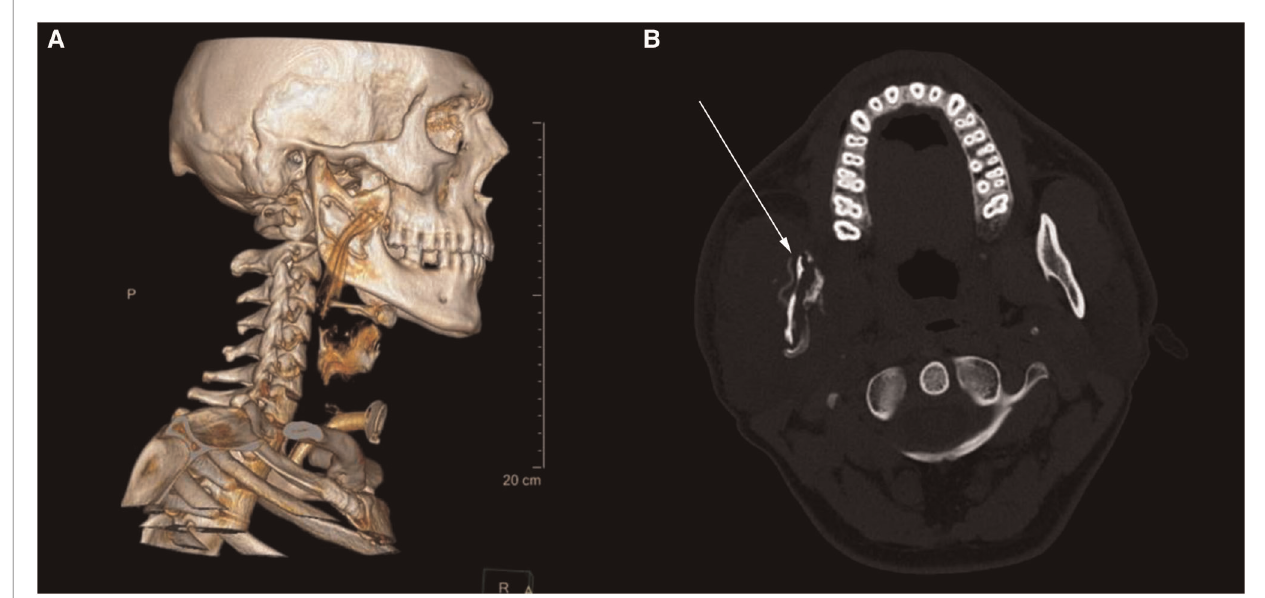
FIGURE 2 | Axial CT scan of the neck at the C1 level after the relapse of the infection. ( A ) 3D reconstruction showing sequestrum of bone with a corrugated drain properly placed above the osteomyelitic site. ( B ) Cross section of the osteomyelitic mandibular ramus — bone is thin with loss of both medulla and cortex. A reconstructive plate was placed so the mandible could withstand masticatory forces.